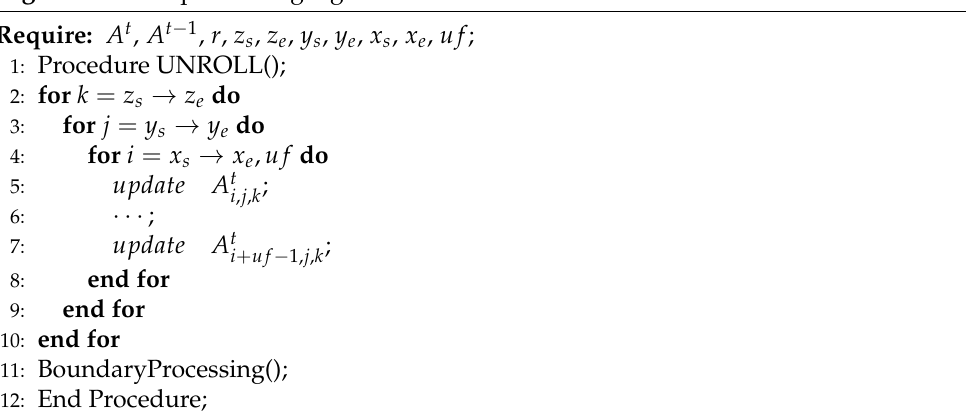
Algorithm 2 Loop unrolling algorithm